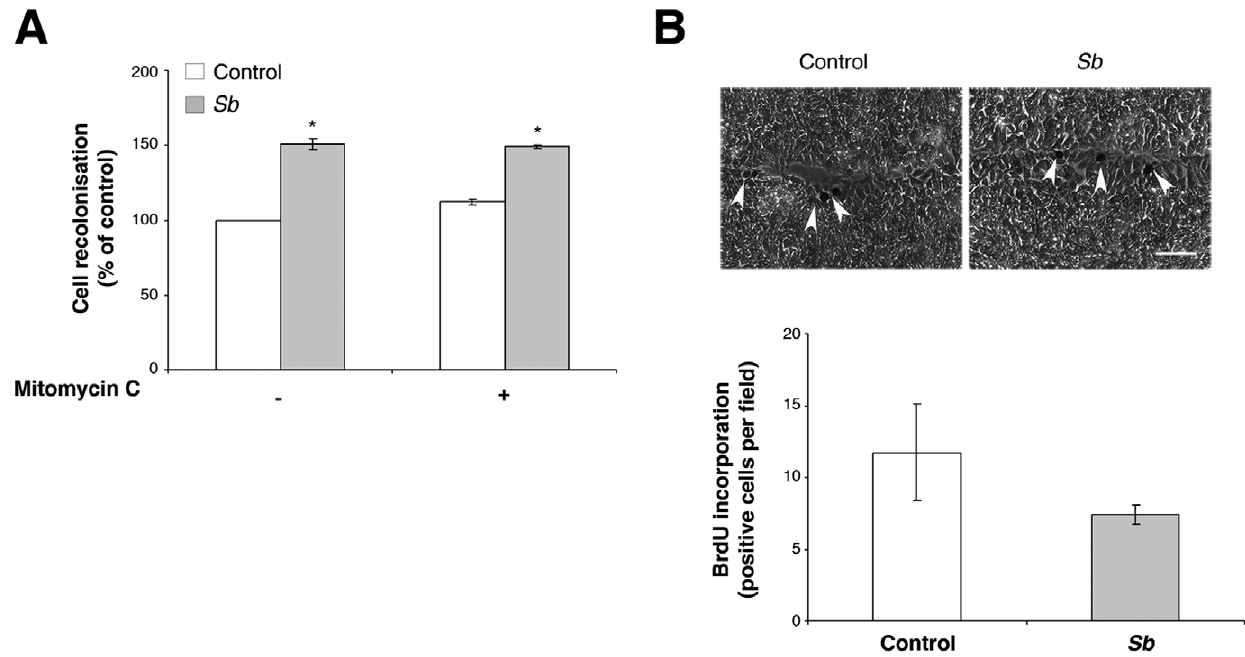
Figure 2. Sb -stimulated cell restitution is independent of cell proliferation. ( A ) HCT-8/E11 cell monolayers were incubated for 2 hours with ( + ) or without ( 2 ) 2.5 m g/mL mitomycin C, wounded and cultured for an additional 5 hours period with or without mitomycin C, in the absence or presence of Sb supernatant. Wound closure was evaluated as described in Methods. Results are expressed as the percentage of cell migration compared to control. Data represent the mean 6 SD of 3 separate experiments. * P , .05. ( B ) Confluent monolayers were wounded and incubated with or without Sb supernatant for 4 hours. BrdU (10 m mol/L) was added and incubation continued for an additional hour. Cells that had incorporated BrdU into their DNA were detected as described in Methods and are indicated by arrowheads. Data shown are from a representative experiment out of 3 performed. Scale bar: 300 m m.